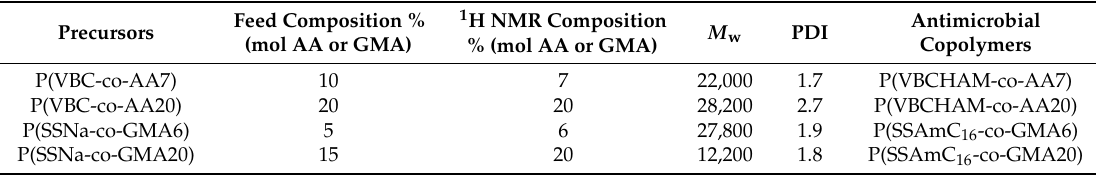
Table 1. Characterization results for the P(VBCHAM-co-AAx) and P(SSAmC 16 -co-GMAx) complementary antimicrobial